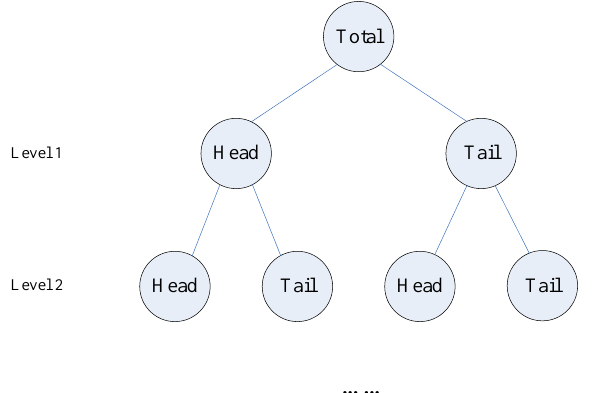
Figure 5. The two-tier hierarchical structure in heavy-tailed